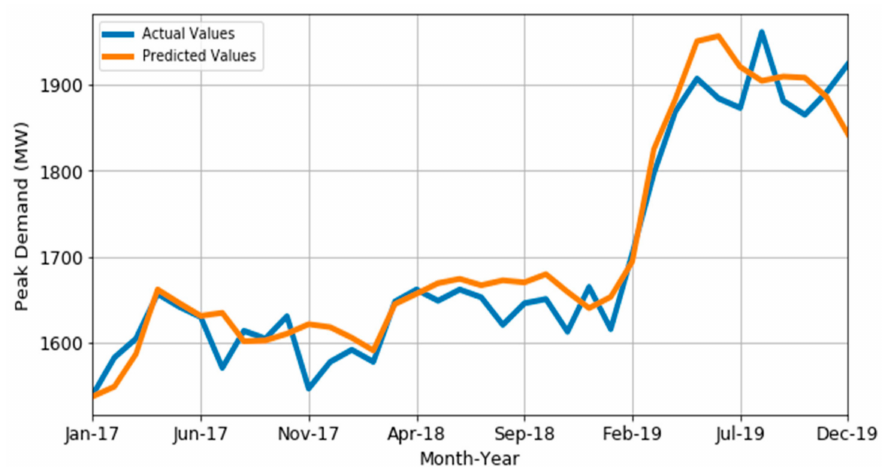
Figure 12. Performance of the multivariate CNN model on the test set.